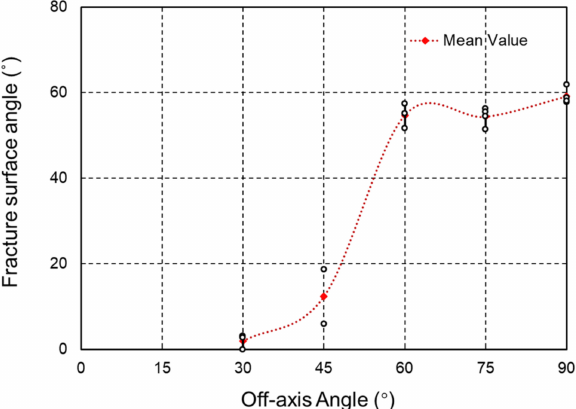
Figure 17. The fracture angles vs. the off-axis